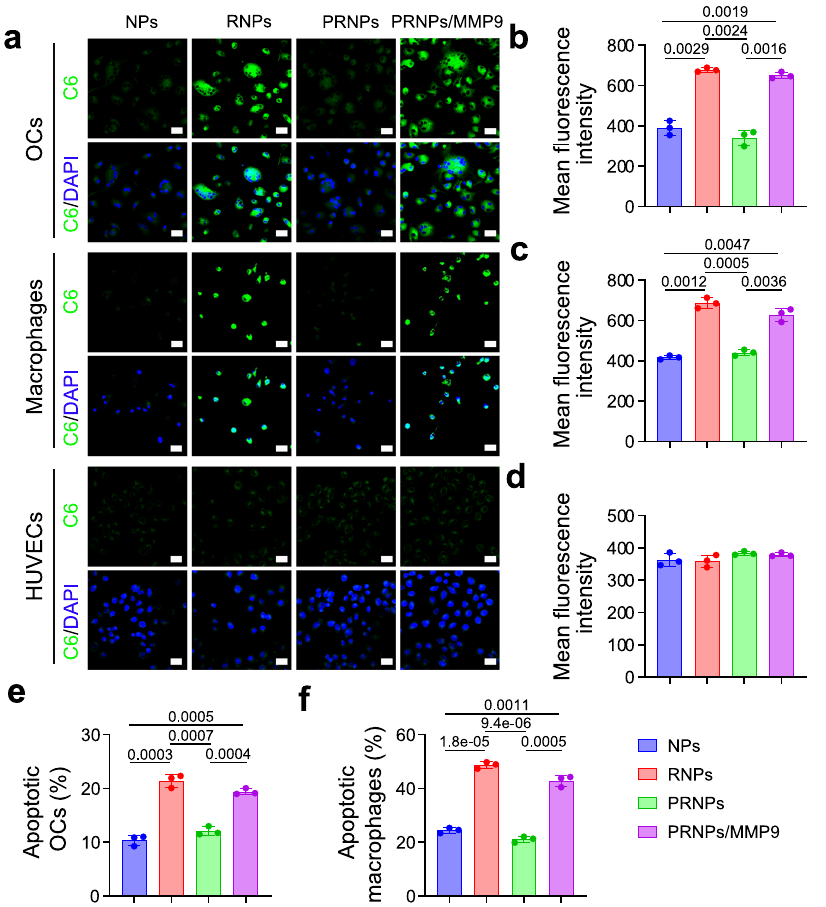
Fig. 4 Increased apoptosis of OCs and synovial macrophages derived from patients with late-stage RA by PRNPs. a Confocal images of the cellular uptake on OCs and synovial macrophages ( n = 3 independent samples). Scale bar = 50 μ m. b – d Quantitative analysis of the cellular uptake of C6-loaded NPs, RNPs or PRNPs on OCs ( b ), synovial macrophages ( c ), and HUVECs ( d ) after 1-h incubation at the C6 concentration of 50 ng/mL. Data represent mean ± SD ( n = 3 independent samples). Statistical signi fi cance was determined by a two-sided Student ’ s t test. e , f Quantitative analysis for the apoptosis of OCs ( e ) and synovial macrophages ( f ) by CEL-NPs, CEL-RNPs, or CEL-PRNPs. Data represent mean ± SD ( n = 3 independent samples).